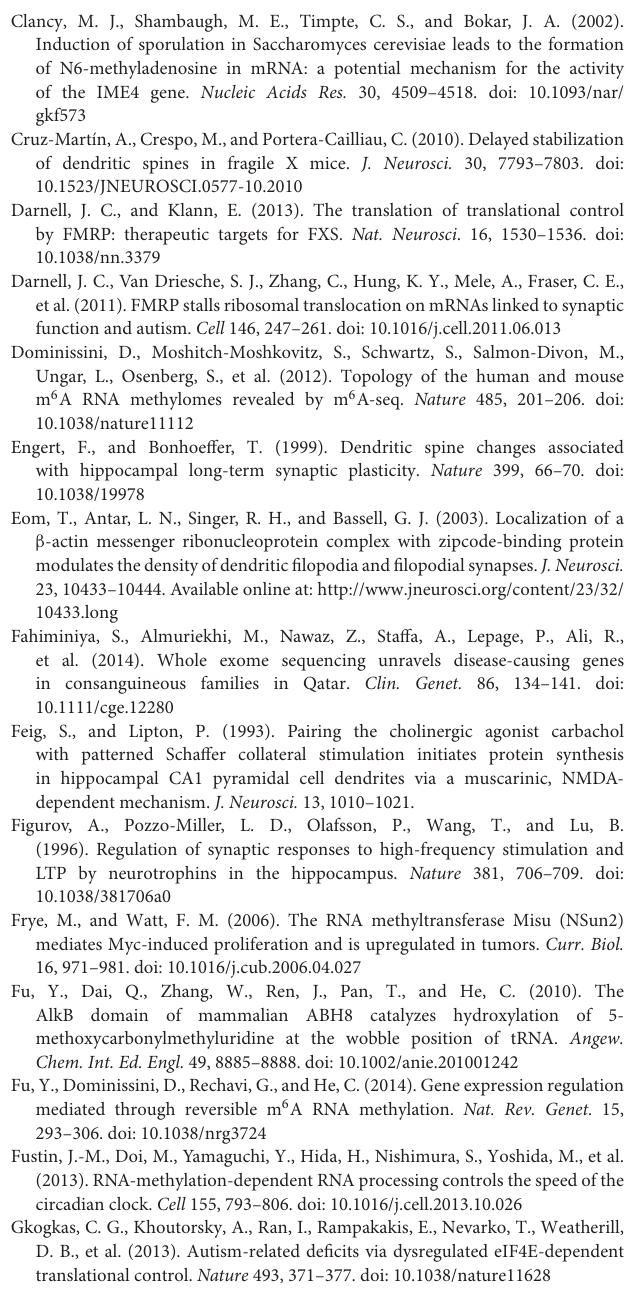
Supplementary Table 1 | miCLIP-generated NSun2 mRNA-target lists, including lists generated following DAVID Bioinformatics analysis,